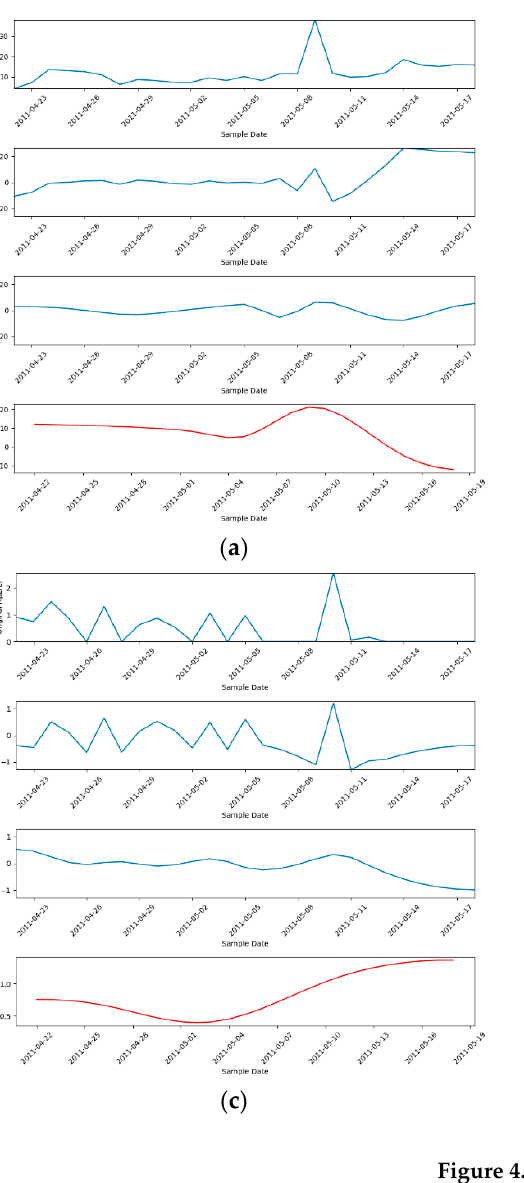
Table 6. Grey relational degree of each